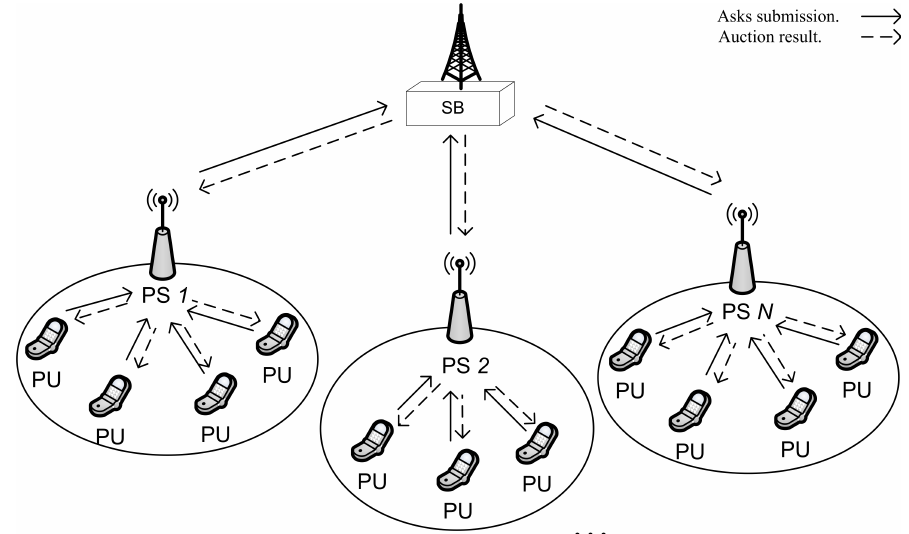
Figure 3. System model. SB, Secondary Buyer; PS, Primary Seller; PU, Primary User.